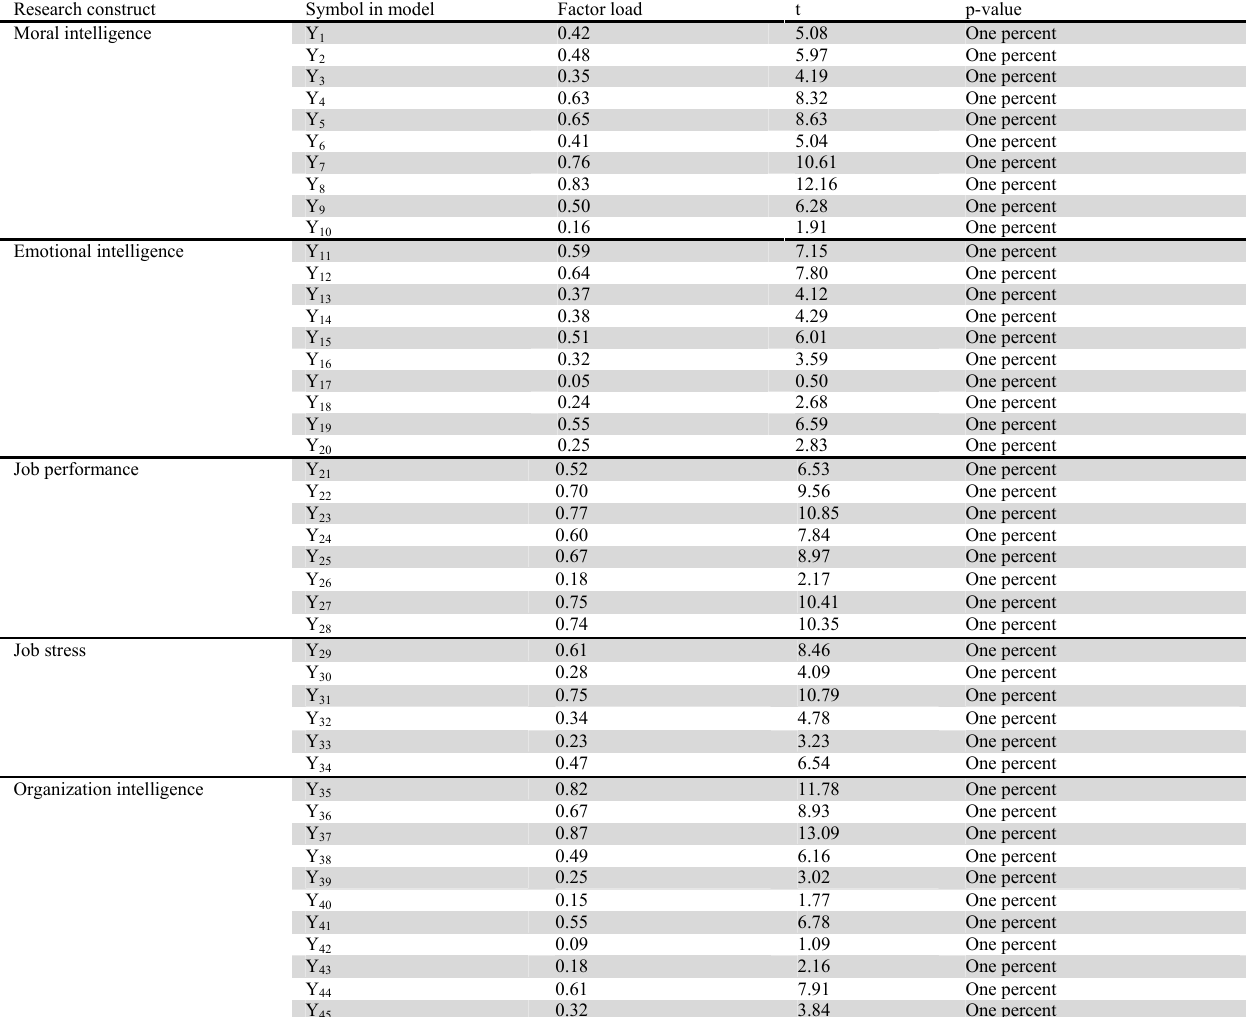
Measurement model results of external variables Research construct